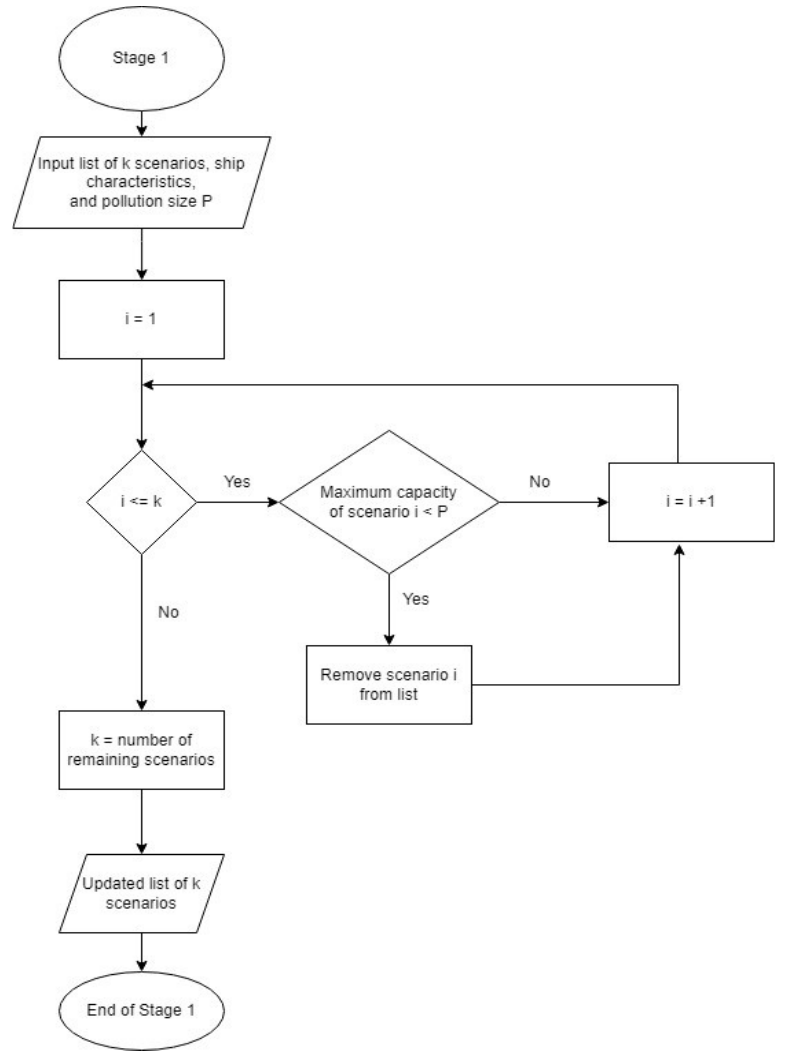
Figure 5. Flowchart for Stage 1.